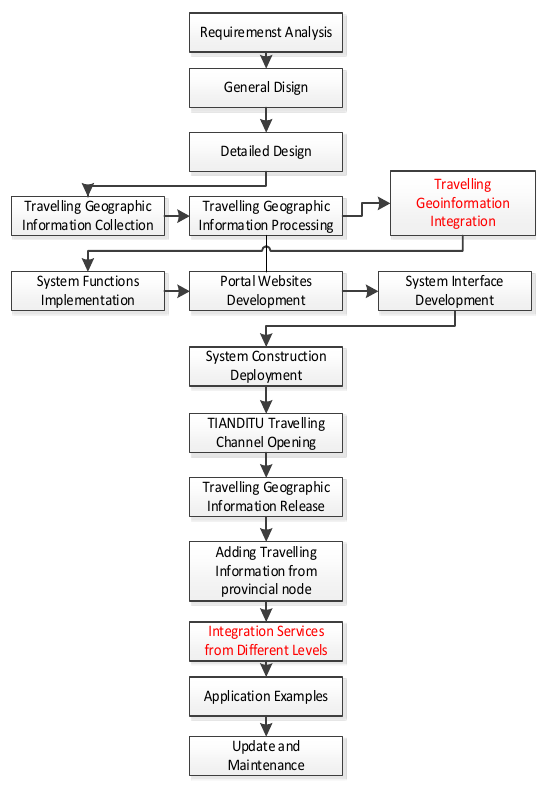
Figure 1: Flow Diagram of System Construction